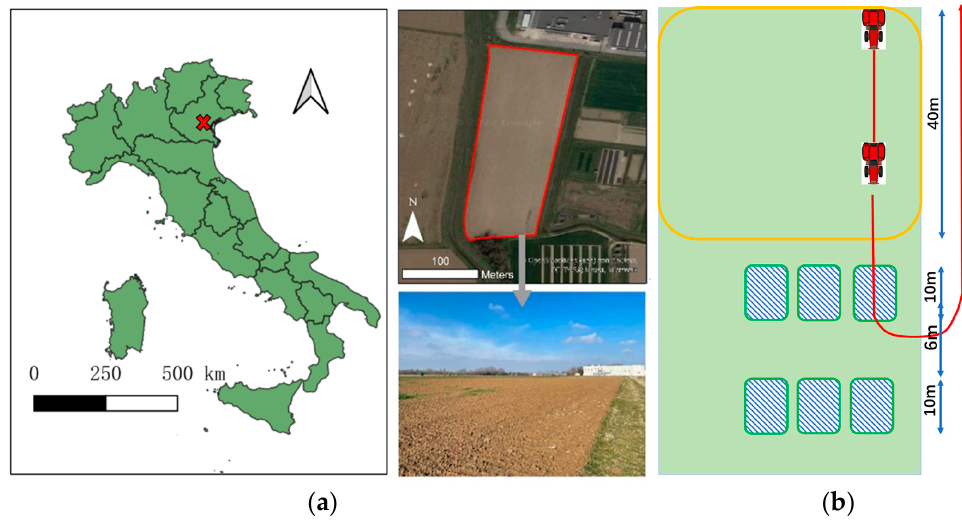
Figure 1. Experiment field in Legnaro, North Italy ( a ), and the experimental procedure ( b ). Two tractors were used in the experiment. The front tractor was used to compact the soil in different traction conditions and number of passes. The rear tractor was designed to use the hydrostatic transmission system to adjust the braking force.